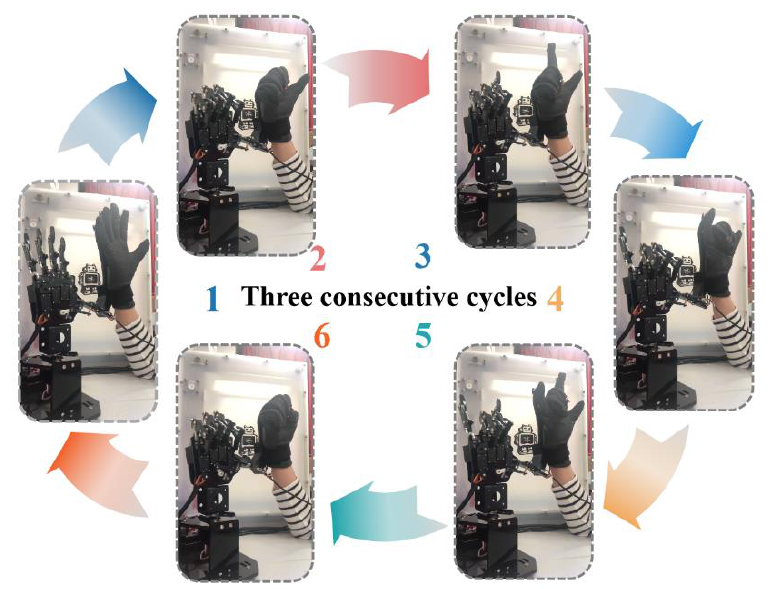
Figure 8. Video screenshots of Video S2. The manipulator tracks the gestures of the data glove in real-time.